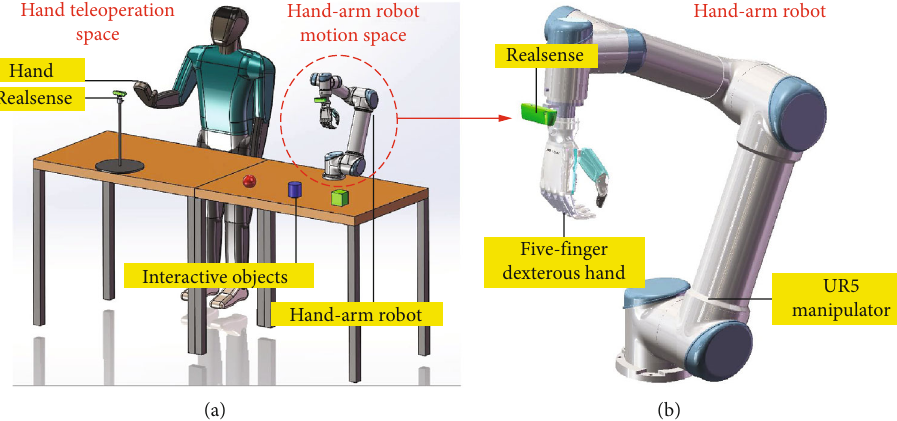
Figure 7: Space robot teleoperation platform. (a) The platform includes a hand teleoperation space and a hand-arm robot motion space. (b) The hand-arm robot includes a UR5 manipulator, a fi ve- fi nger dexterous hand, and a